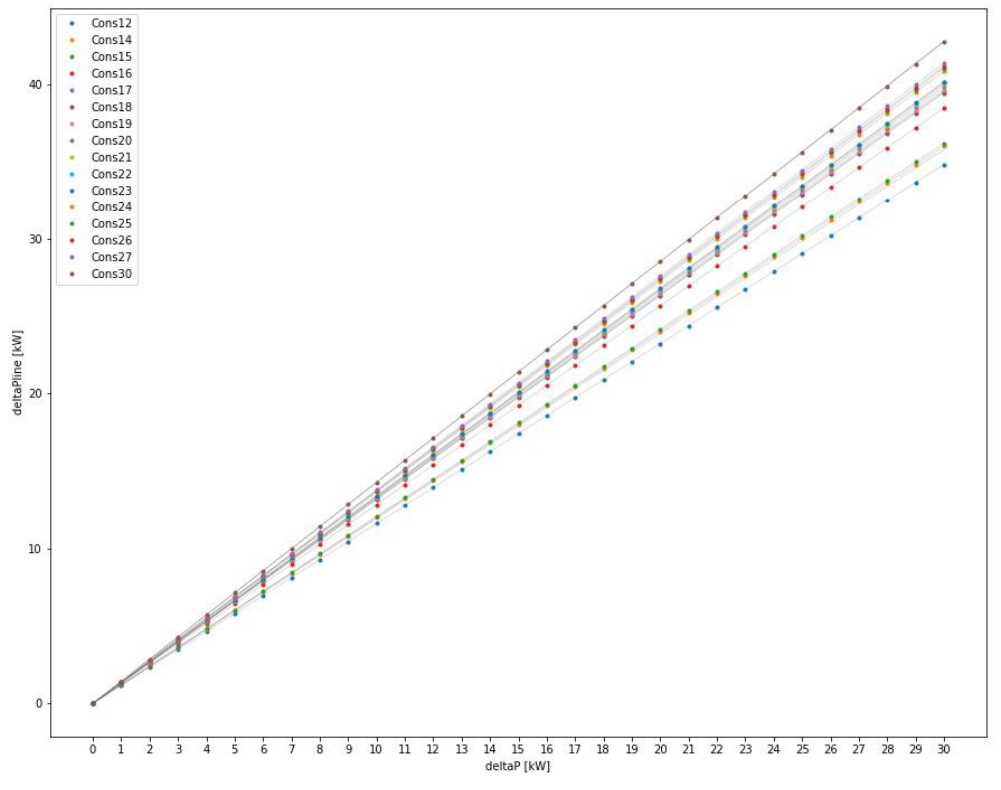
Figure 6. Dependences of change in loading of line 14 on changes in loading of consumers nodes for one congestion event. Table 1. Impact of change in active power consumption of flexibility provider/asset on change in load of a congested line for given line congestion event.